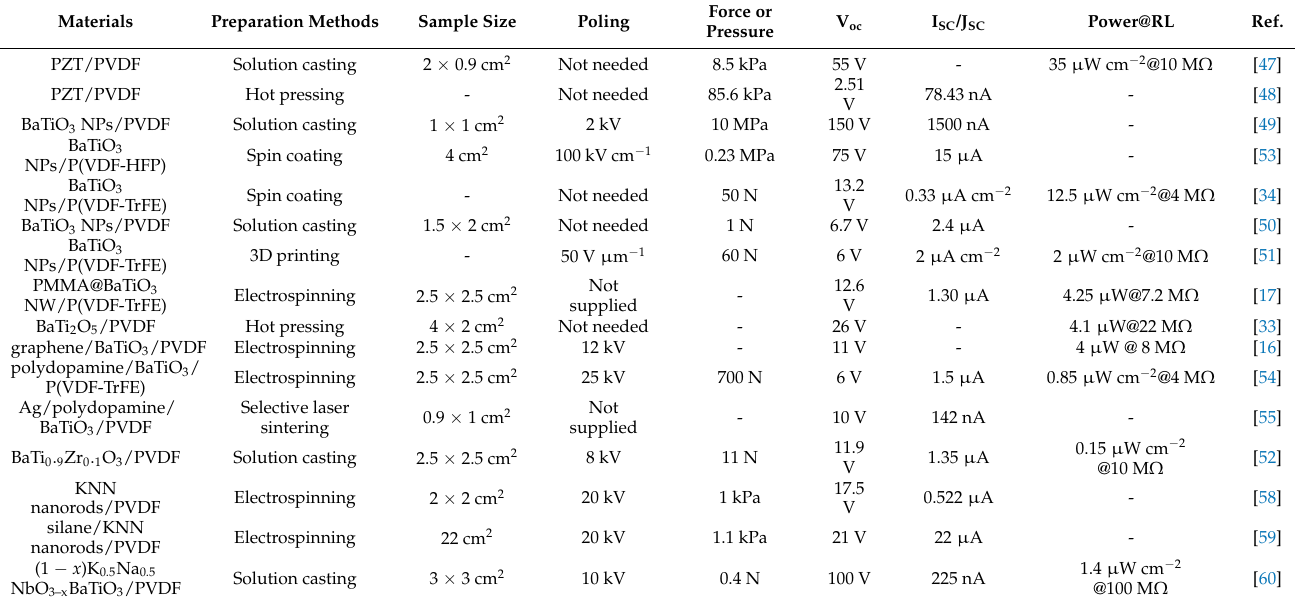
Table 2. Performances of the PVDF-based metallic oxide perovskite